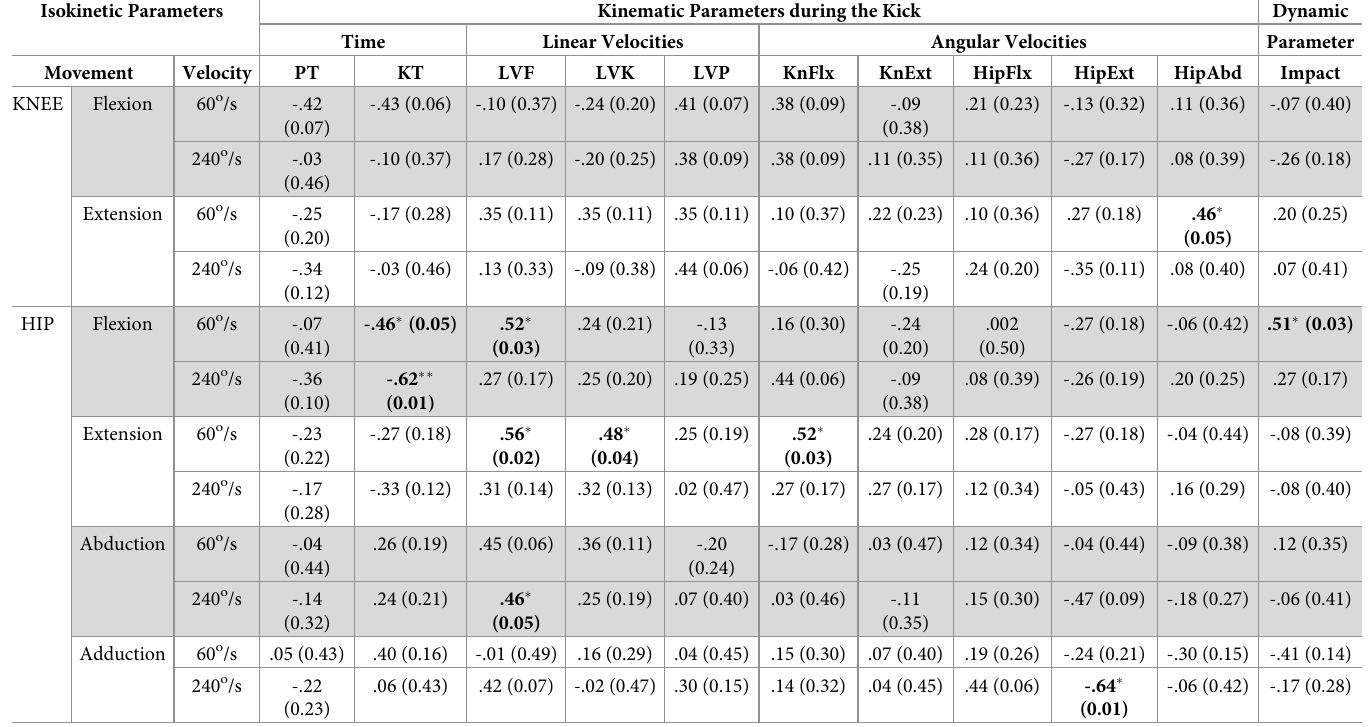
Table 2. Coefficients of correlation between the isokinetic peak torques and the temporal, kinematic, and impact data obtained during the bandal chagi kick (n = 14 athletes as a single group). Isokinetic Parameters